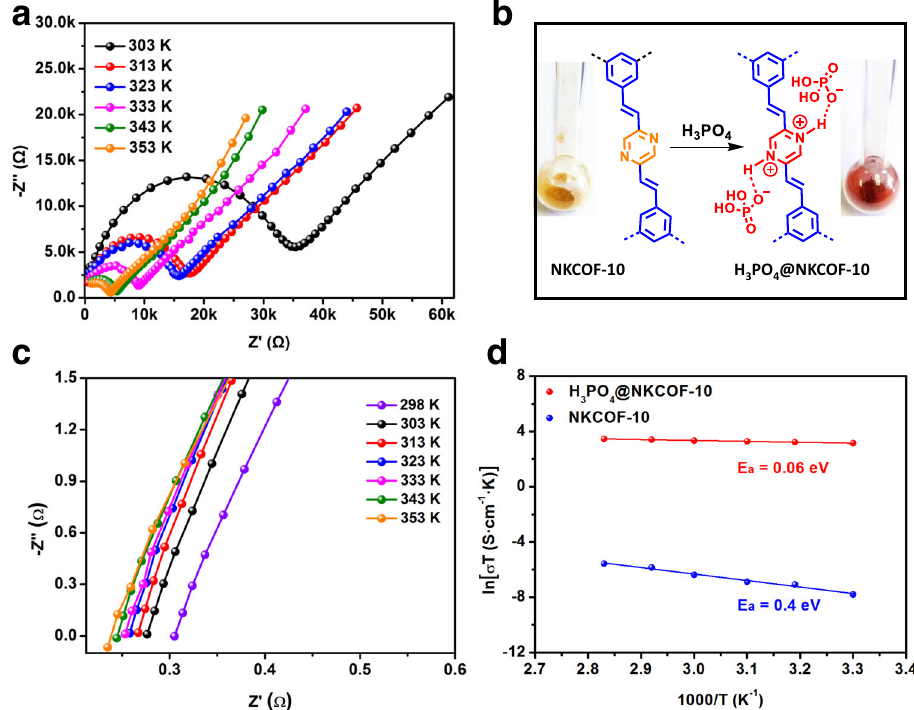
Fig. 4 Proton transport and activation energy. a Nyquist plots of NKCOF-10 measured under 90% RH at different temperatures. b Protonation of the pyrazine moieties with H 3 PO 4 . c Nyquist plots of H 3 PO 4 @NKCOF-10 under 90% RH at different temperatures. d Arrhenius plots for NKCOF-10 (blue) and H 3 PO 4 @NKCOF-10